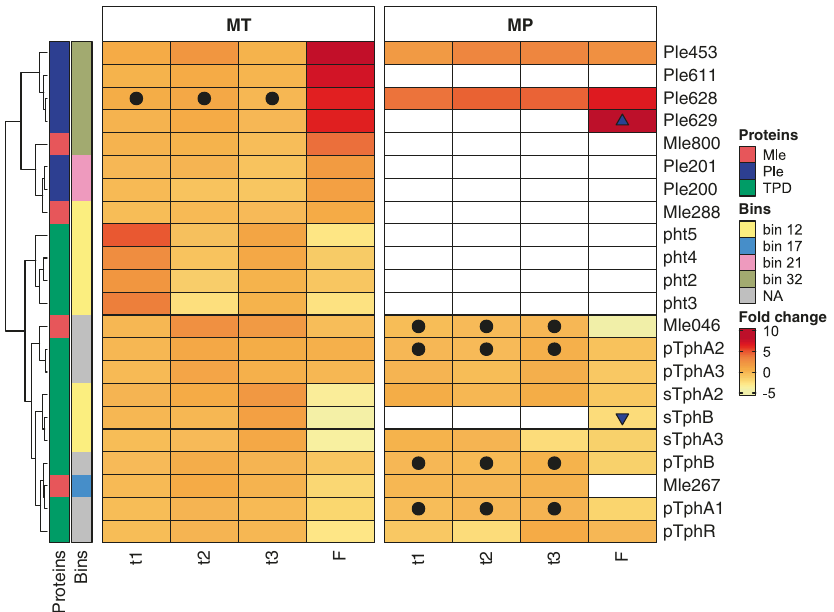
Fig. 5 Heatmap of PF degradation genes and proteins. Fold change pro fi les of genes potentially involved in PF biodegradation at the metatranscriptome (MT) and metaproteome (MP) level during different time points t1, t2, t3 and in the fi lm-attached (F) community. The fold changes in (F) equal to the same amount of fold change in the free-living community with the opposite sign. The average of at least two biological replicates were used to calculate fold changes. Ples (blue): ple453 , ple628 , ple611 , ple629 , ple201 , ple200 ; Mles (red): mle046 , mle267 , mle800 , mle288 ; TPD cluster genes (green): stphA2A3B and ptphA2A3BA1R , and pht cluster genes: pht3524 . Filled circles represent non-differential gene expression and protein biosynthesis along different time points. Blue- fi lled triangles indicate proteins unique in the fi lm-attached fraction (up-pointing triangle) and unique in the free-living fraction (down-pointing triangle). The scale shows log2-transformed fold changes. Upregulated transcripts and proteins are shown in shades of red. Downregulated transcripts and proteins are shown in shades of yellow. Bins are represented by different colors. Samples were clustered according to the highest fold-change in the metatranscriptome. Source data are provided as a Source Data fi